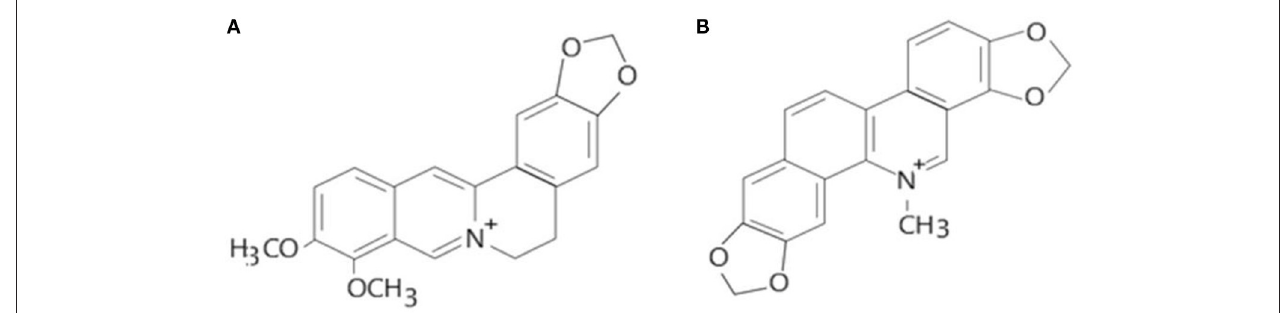
FIGURE 1 | Molecular structures of berberine (A) and sanguinarine (B) (Source: Hao et al., 2014).